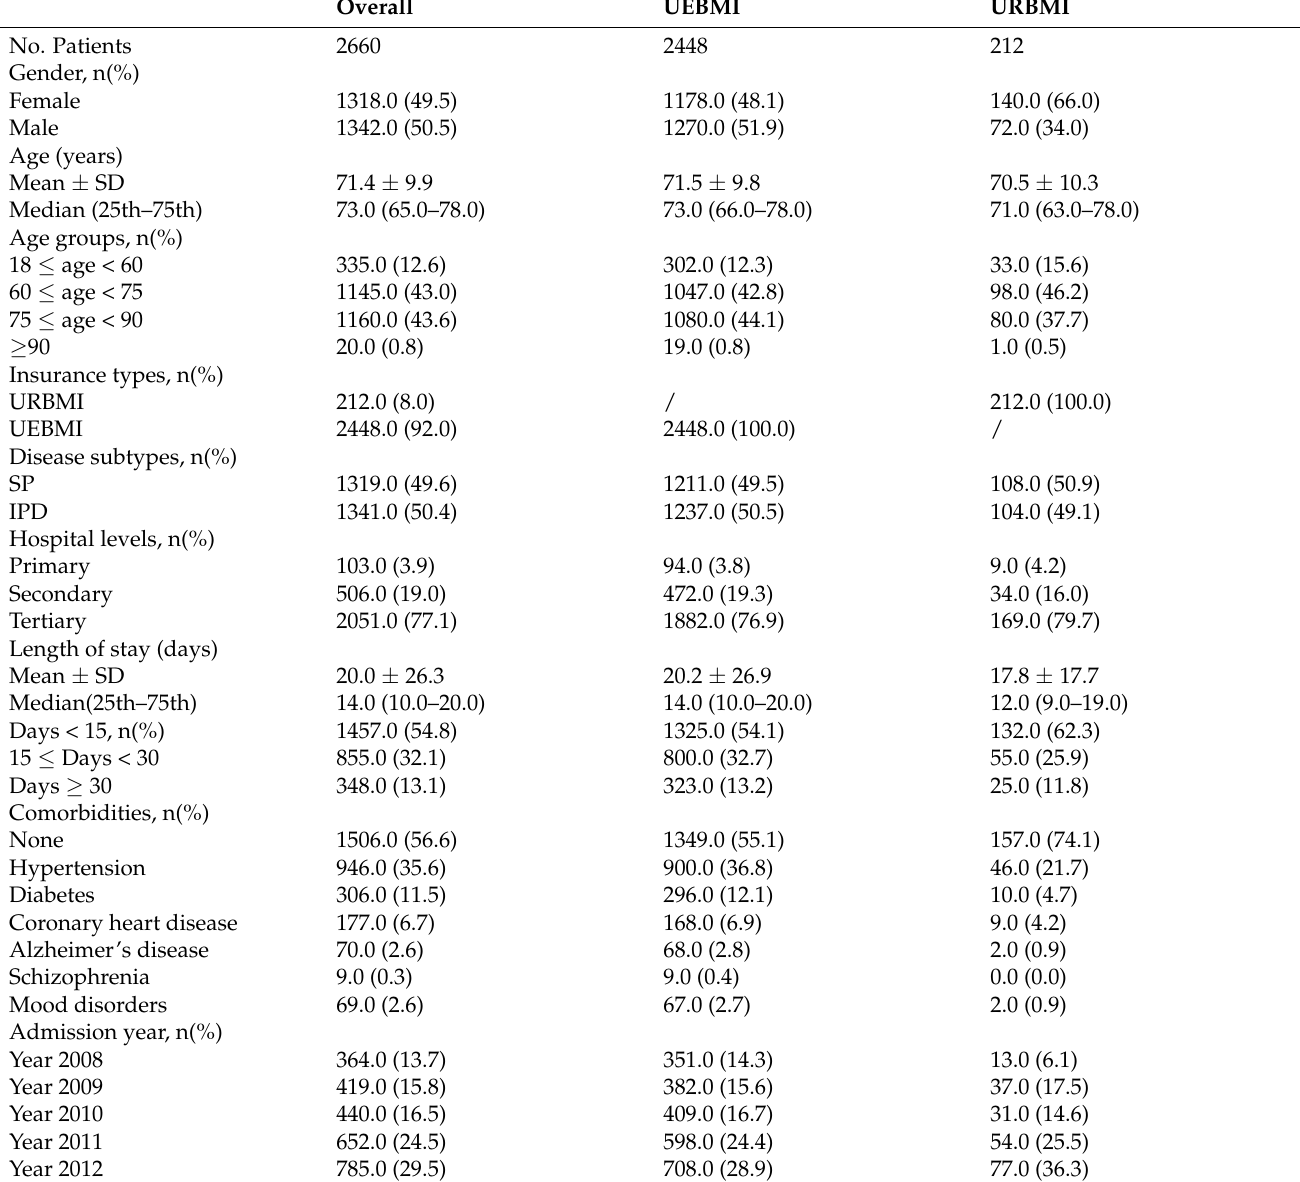
Table 4. Parkinson’s disease patient